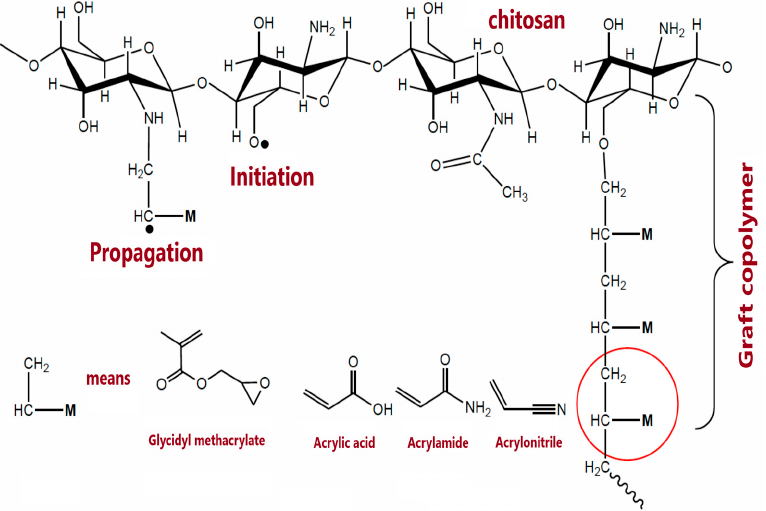
Figure 6. Scheme of binary graft copolymerization. Reprinted from [101], Sensors 2022.